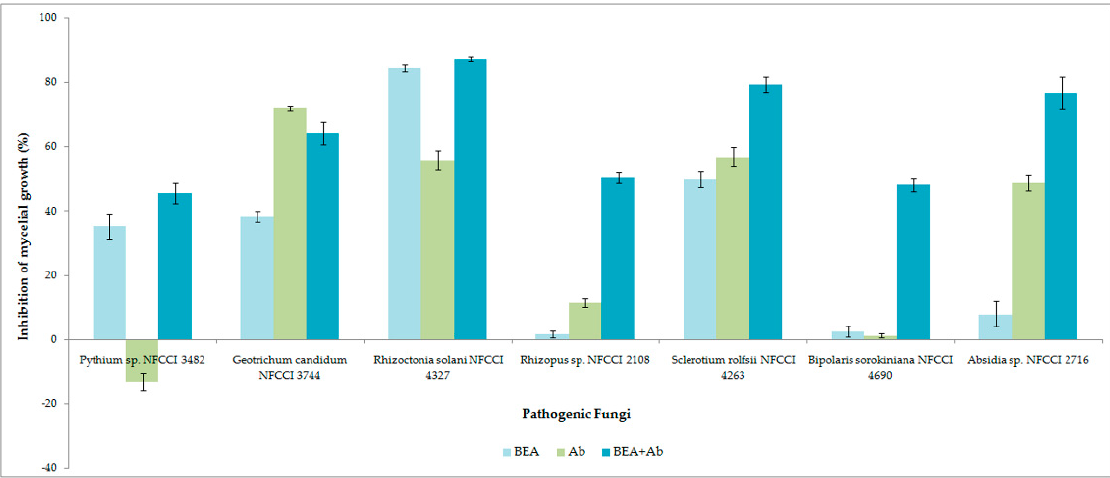
Figure 10. Inhibition of mycelial growth (%) of individual and combined effect of extract of F . tardi- crescens NFCCI 5201 containing beauvericin and amphotericin B on various pathogenic fungi using food poison technique.